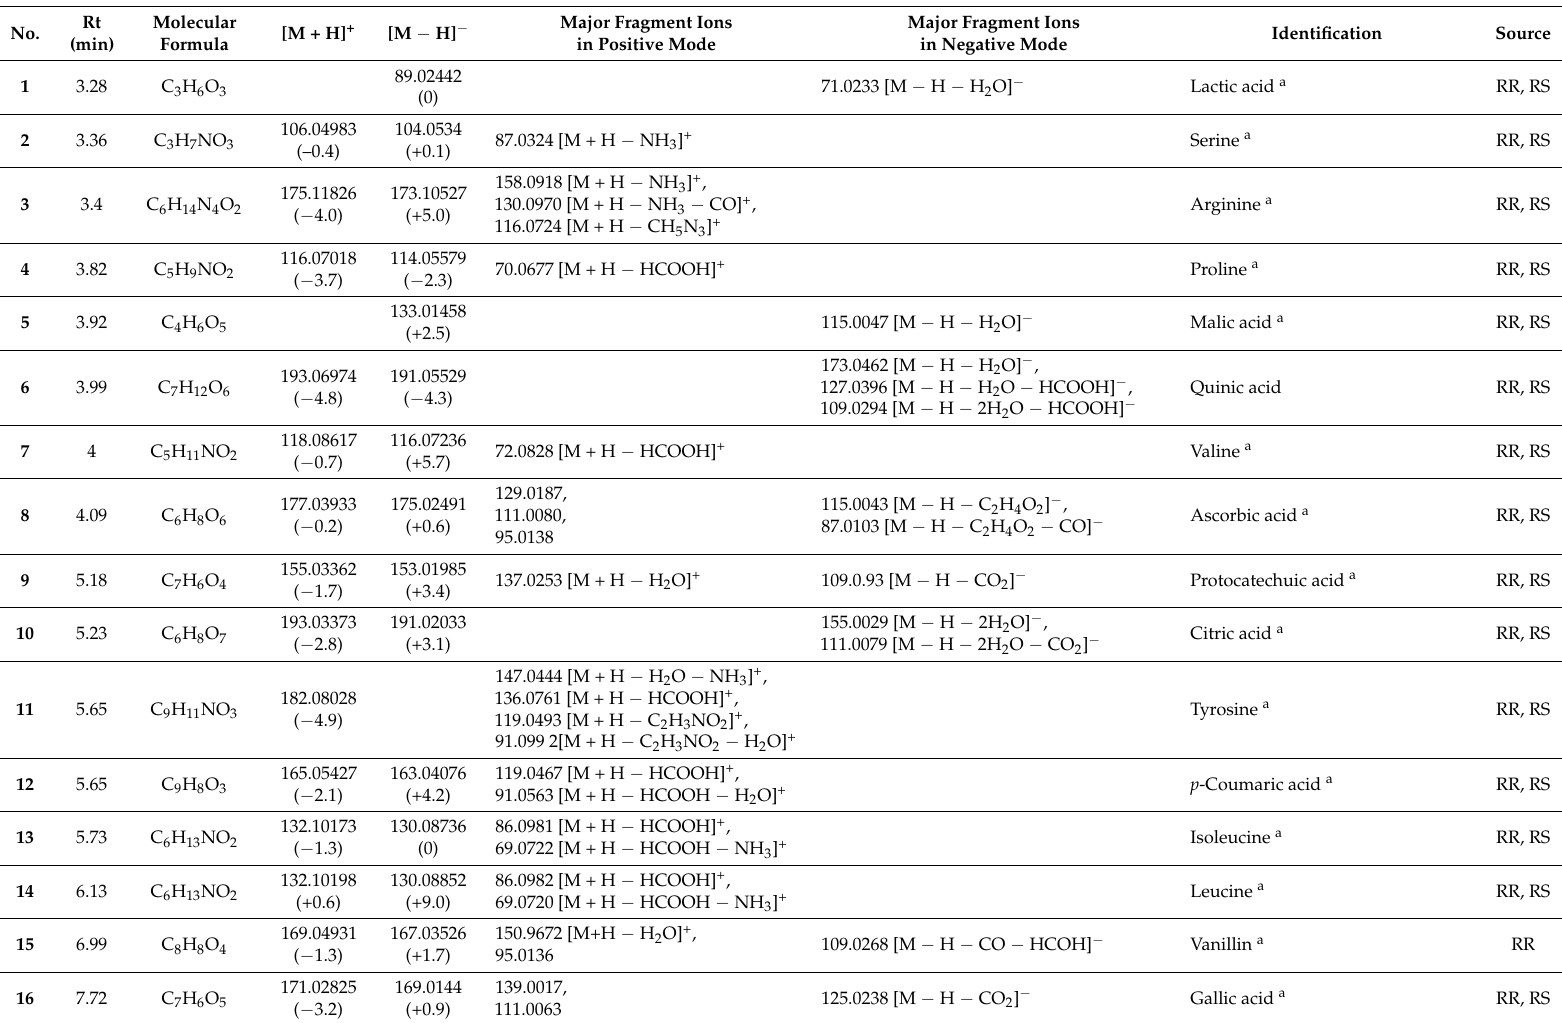
Table 2. Compounds identified in the methanol extracts of R. roxburghii and R. sterilis